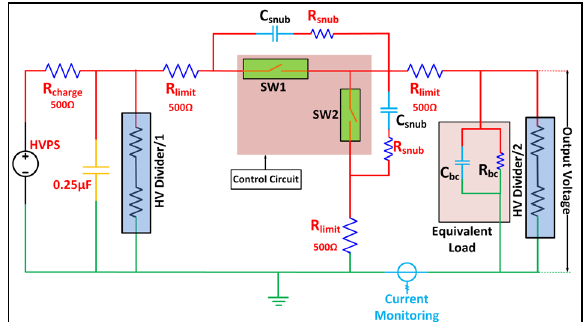
Fig. 5 : Schematic of the tests setup of prototype BPS using solid state